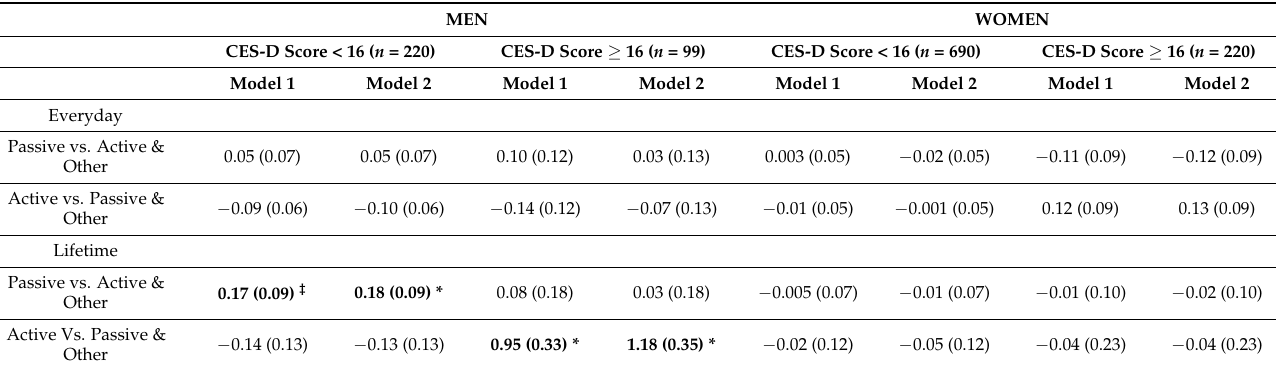
Table 3. Mean differences (standard errors) in leukocyte telomere length by coping with perceived discrimination and depressive symptoms among men and women, Jackson Heart Study